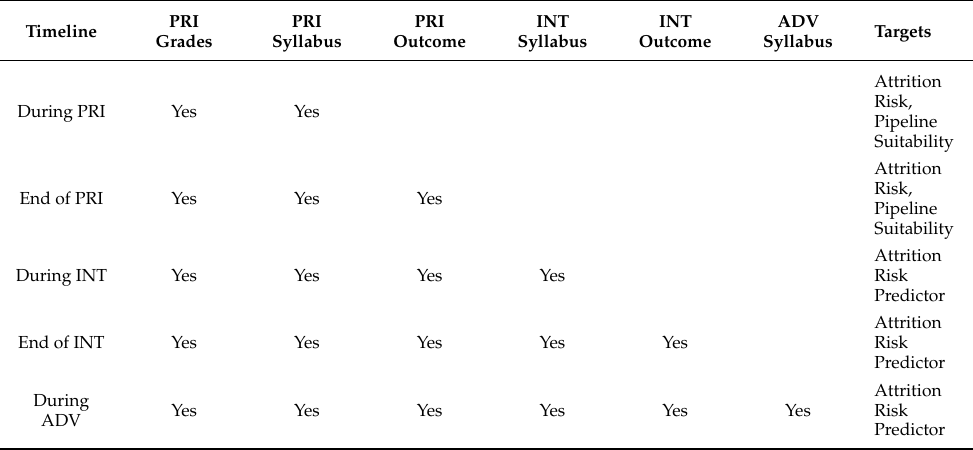
Figure 9. Depiction of the different machine learning models and when they would be leveraged. Table 1. Data available at different stages of training and ML models